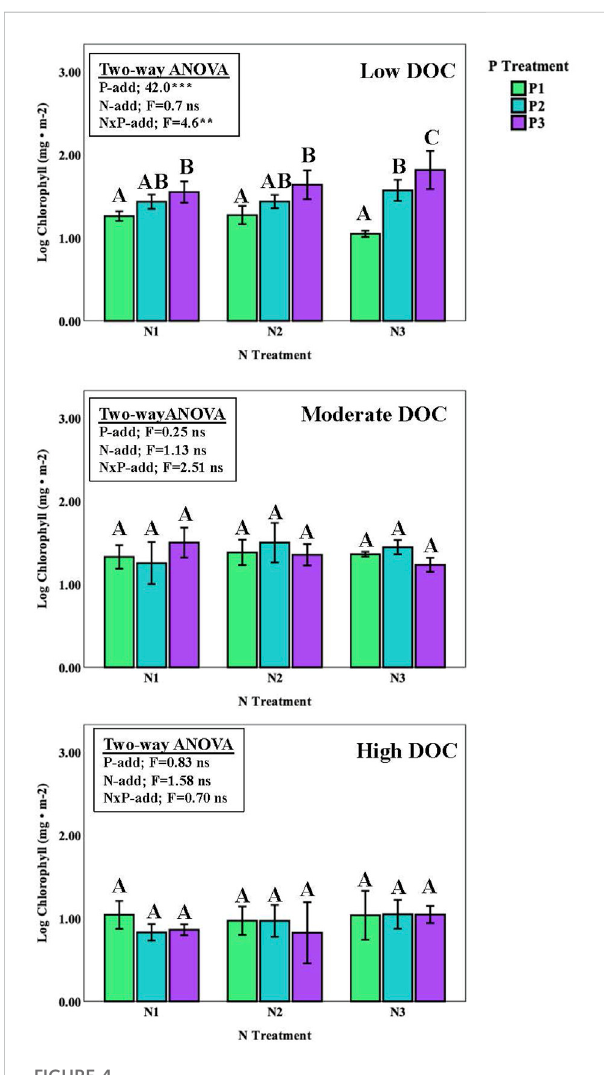
FIGURE 4 Chlorophyll concentrations (average ± one standard error) for benthic algal assemblages in response to varying levels of N and P enrichment (9 nutrient loading treatments). Common lettering joins treatments where no signi fi cant differences were observed (TukeyHSDpairwisecomparisons, p < 0.05).OnewayANOVAwasrun separately (blocked) for site and nitrogen